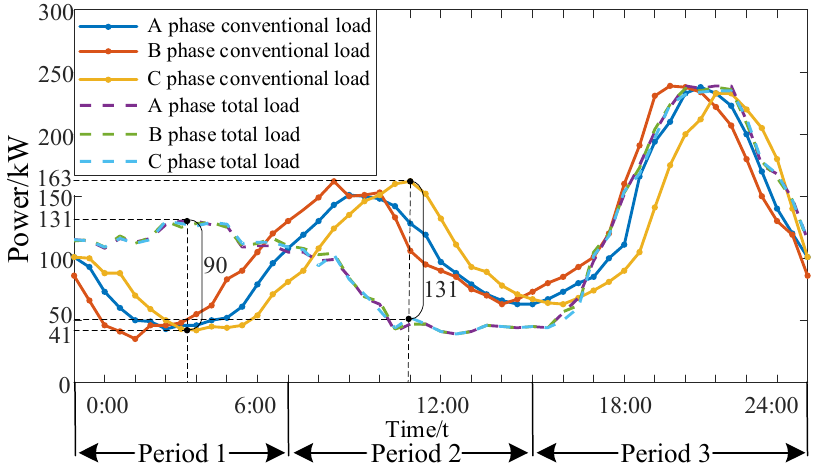
Figure 9. Curves of conventional load and optimized total load of each phase.